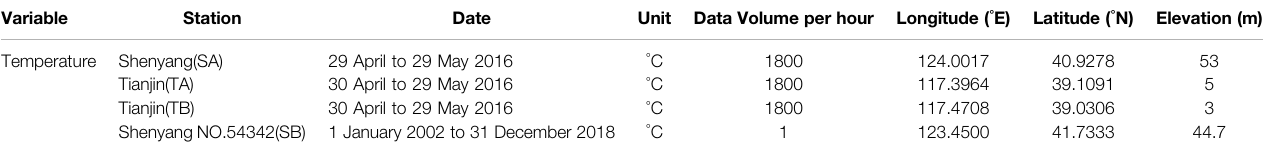
TABLE 1 | The temperature records at Shenyang and Tianjin